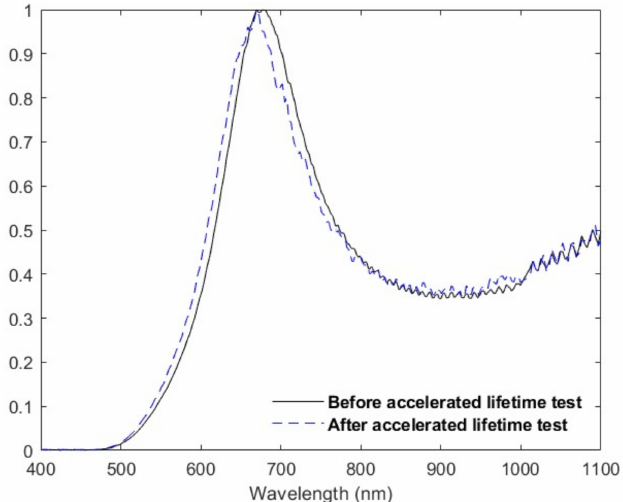
Figure 9. Comparison of MOE transmission spectrum before and after accelerated lifetime